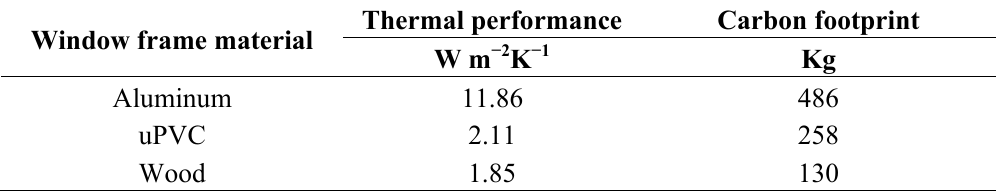
Table 6. Thermal performance and carbon footprint of aluminum, uPVC, and wood window frame with 1 m 2 glazing